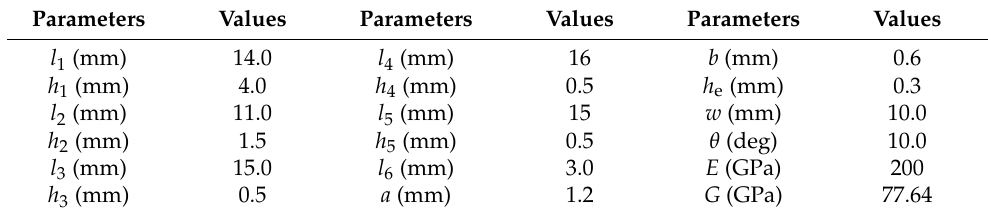
Table 1. Geometric and material parameters of the platform.